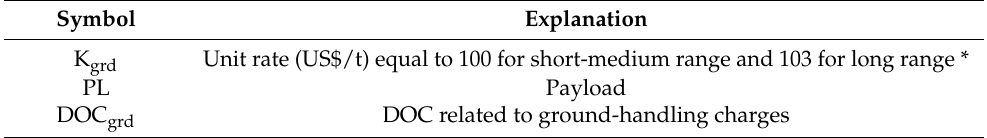
Table 7. Ground handling cost symbols explanation.